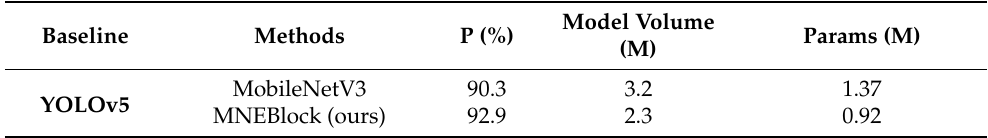
Table 8. The ablation study of MNEBlock on the SSDD